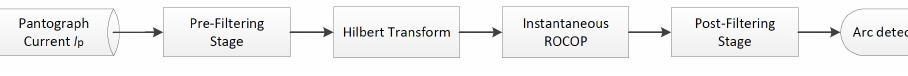
Figure 3. Flow chart of the proposed